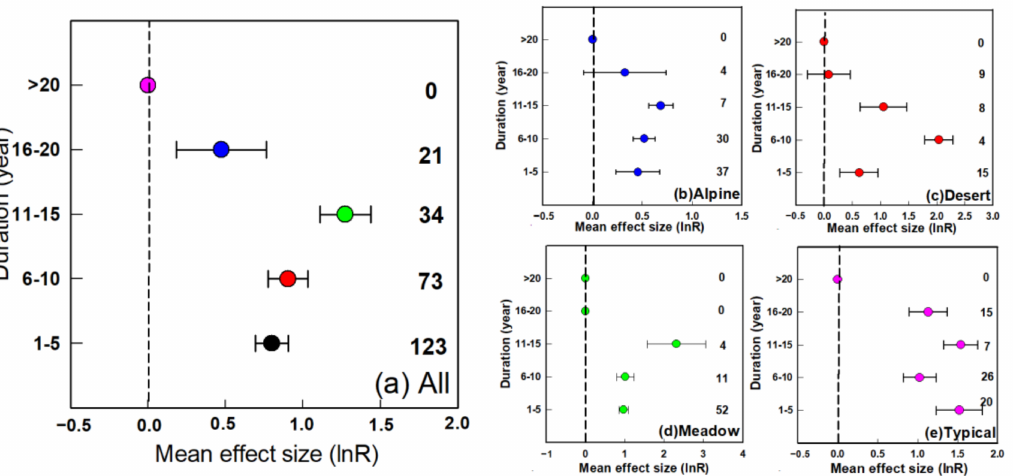
Figure 5. The effect value of aboveground biomass under different enclosure years ( a ), as well as the reaction of different types of grassland aboveground biomass to enclosure, were determined. ( b – e ). The values are calculated effect sizes and 95% confidence intervals. Sample sizes are given to the right of the